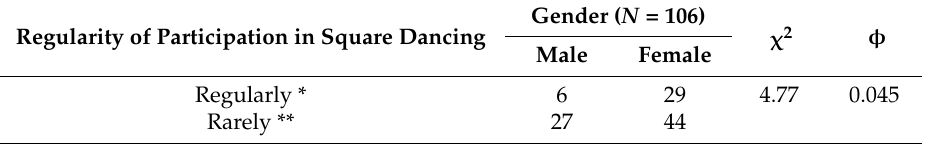
Table 10. Chi Squared Test comparing gender to regularity of participation in Square Dance Activities. Regularity of Participation in Square Dancing